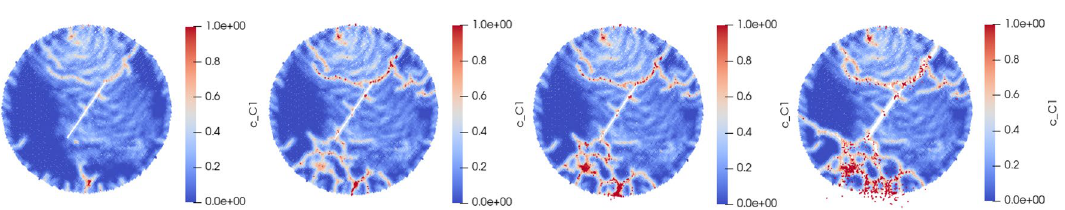
Figure 10. Shear energy change and damage of prefabricated 30° cracked rock materials.